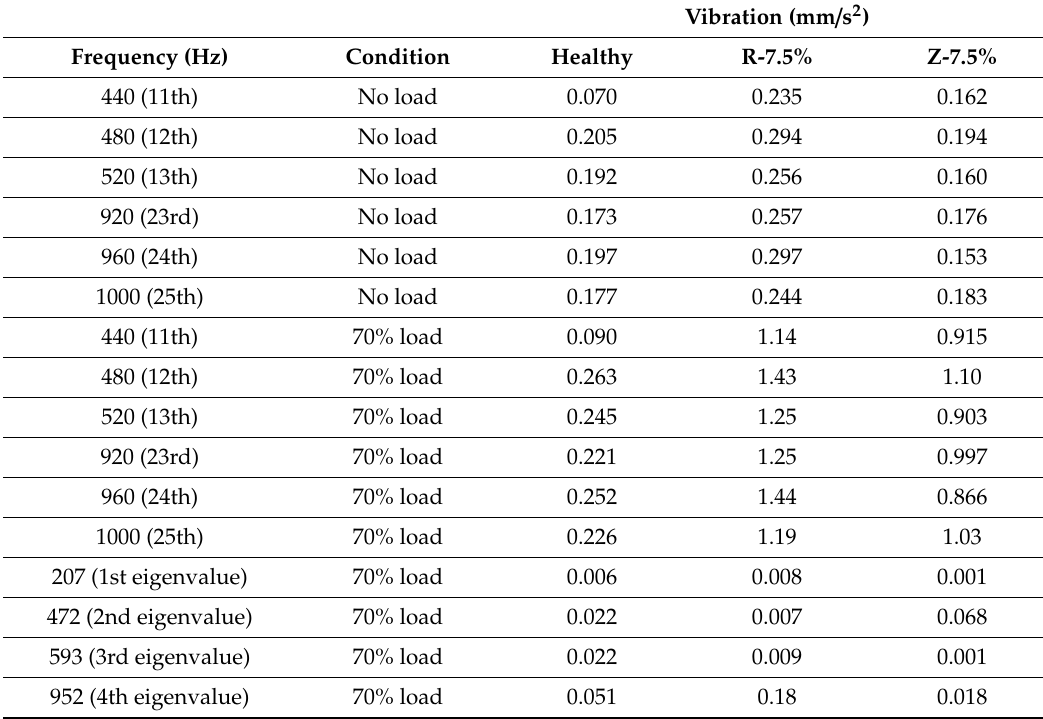
Table 3. Calculated amplitudes of